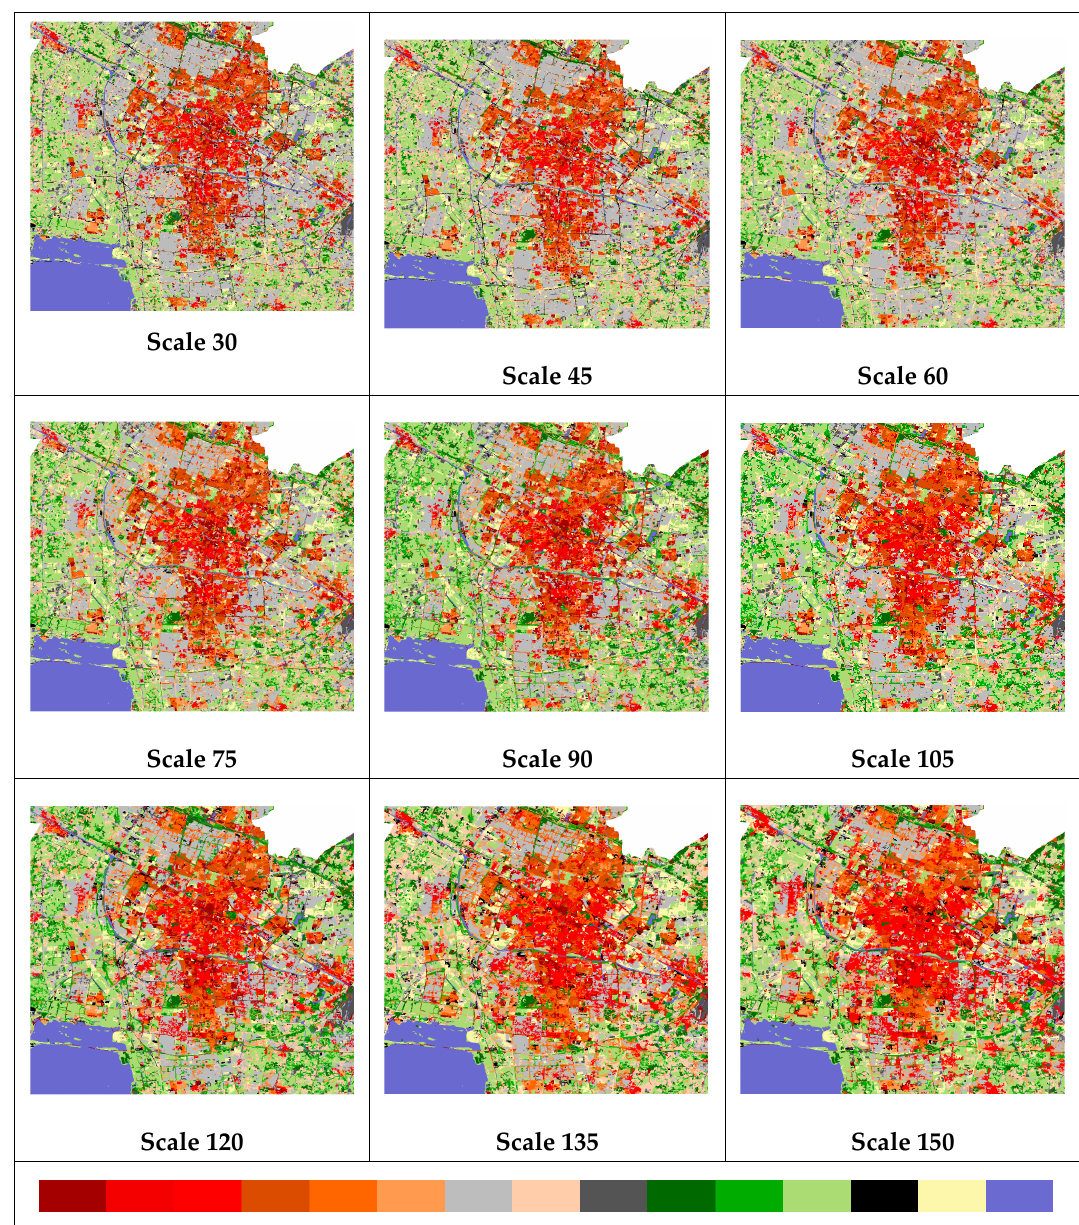
Figure 6. LCZ maps in multi-scale scenarios.